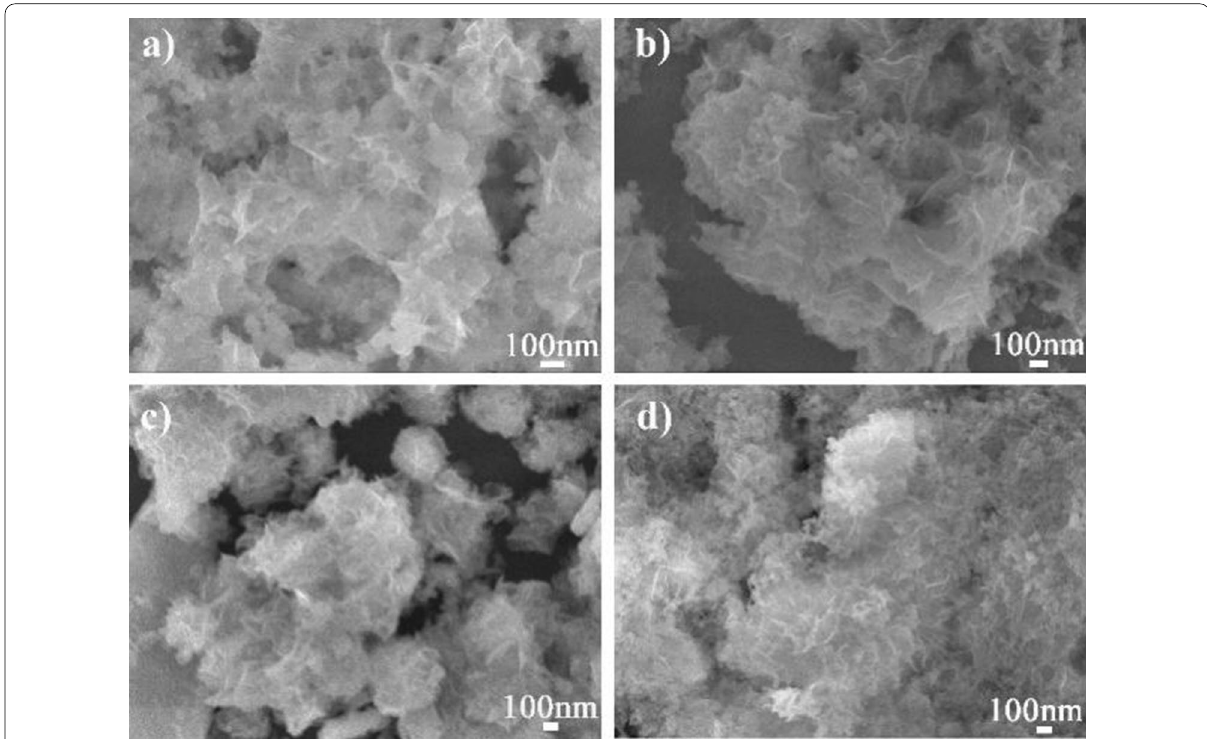
Fig. 2 SEM images of CeCdW 12 nanoflowers which were prepared using different amount of CdCl 2 3.5